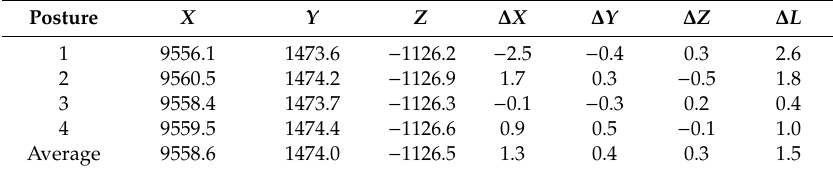
Table 4. Measured X, Y , and Z coordinate values (unit: mm) and their deviations from the true values with the external receiver array held in four di ff erent postures. Here, ∆ L =